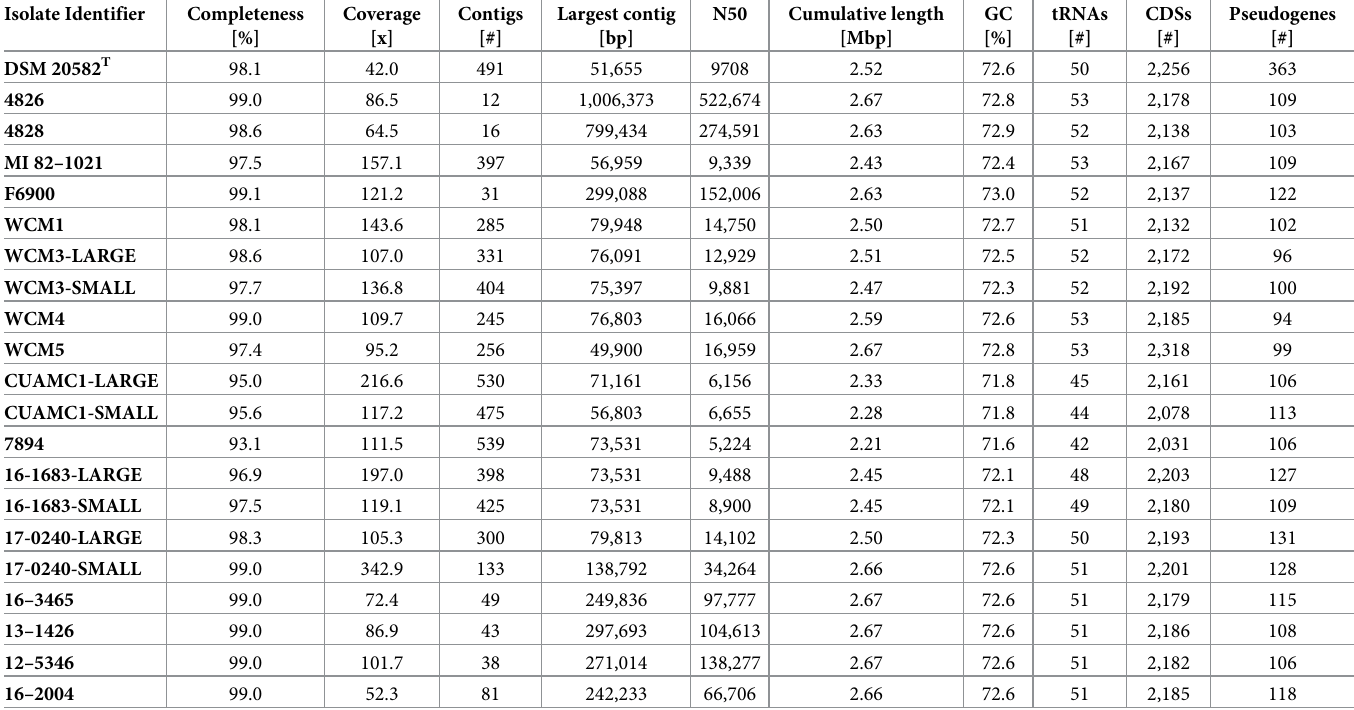
Table 2. Genomic features of 21 C . bovis